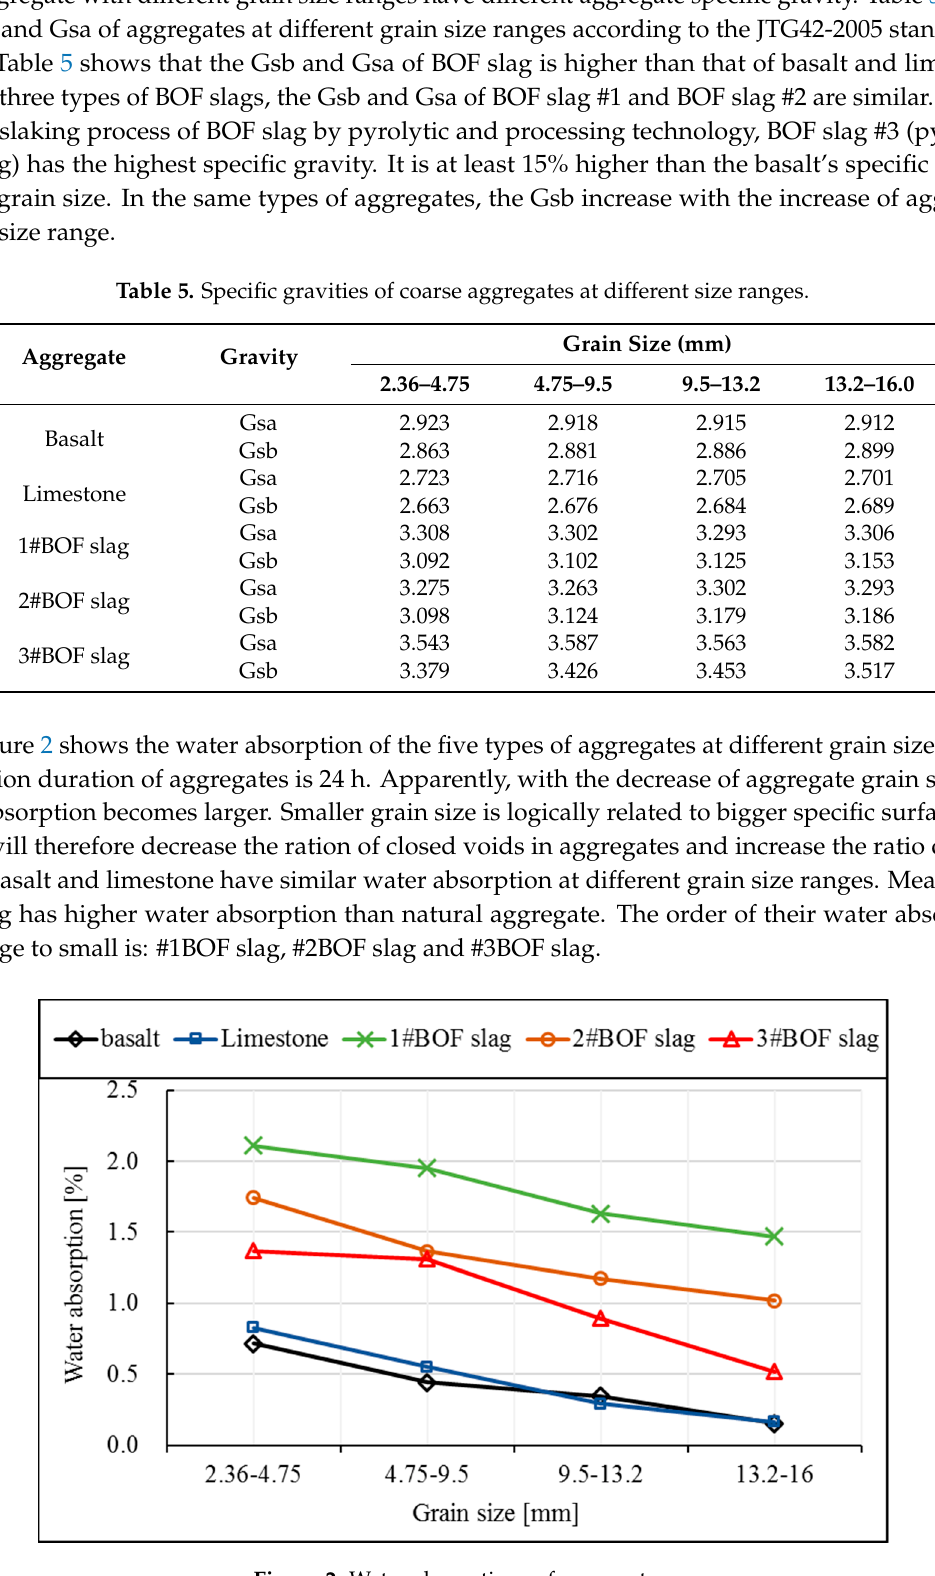
Figure 2. Water absorptions of aggregates.